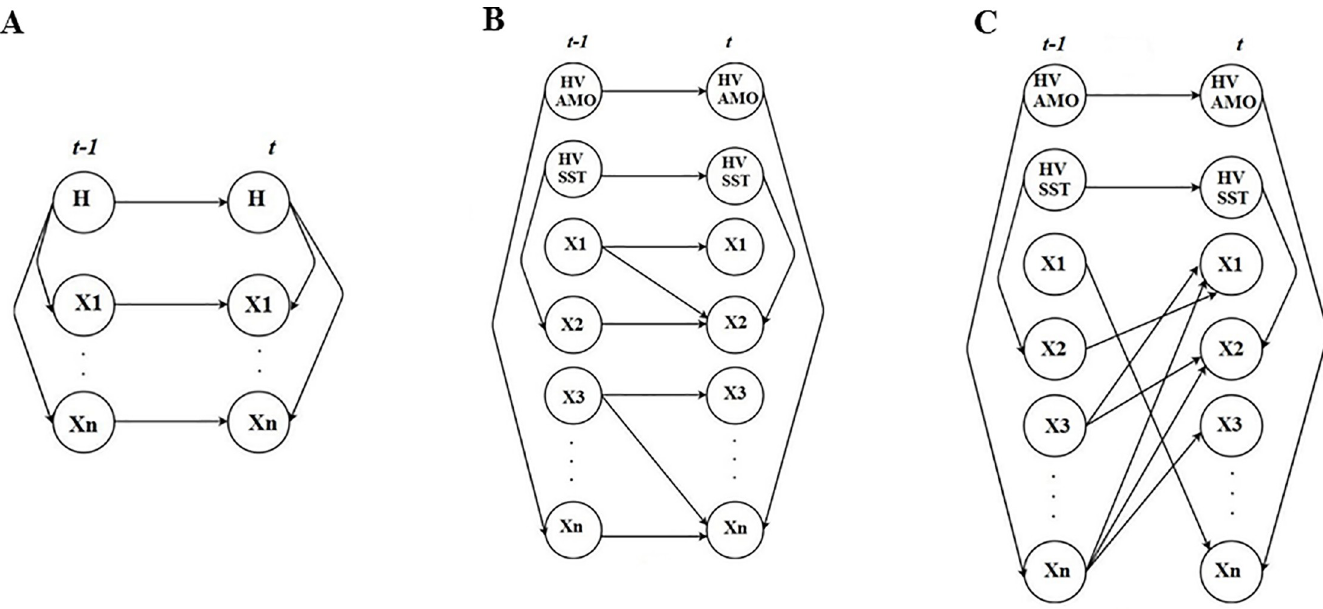
Fig 2. ARHMM, ARDBN and DDDBN models. (A) An autoregressive hidden Markov model (ARHMM), where H denotes an unmeasured hidden variable. X 1 ... XN denote the measured ecosystem components from Table 1. (B) General structural form of the autoregressive DBN (ARDBN). Note, the autoregressive link is kept and an additional parent node is enforced to different children’s nodes. (C) General structural form of the data-driven DBN (DDDBN). Note, the autoregressive link is removed (except for the two hidden variables) and an additional parent node is enforced with the number of parents varying between the different children’s nodes. These are graphical representations to visualize the differences between the model variants. The actual links between the different X nodes are presented in Fig 3. Note, the network linkages and parameters do not change throughout time, the models are time-invariant.